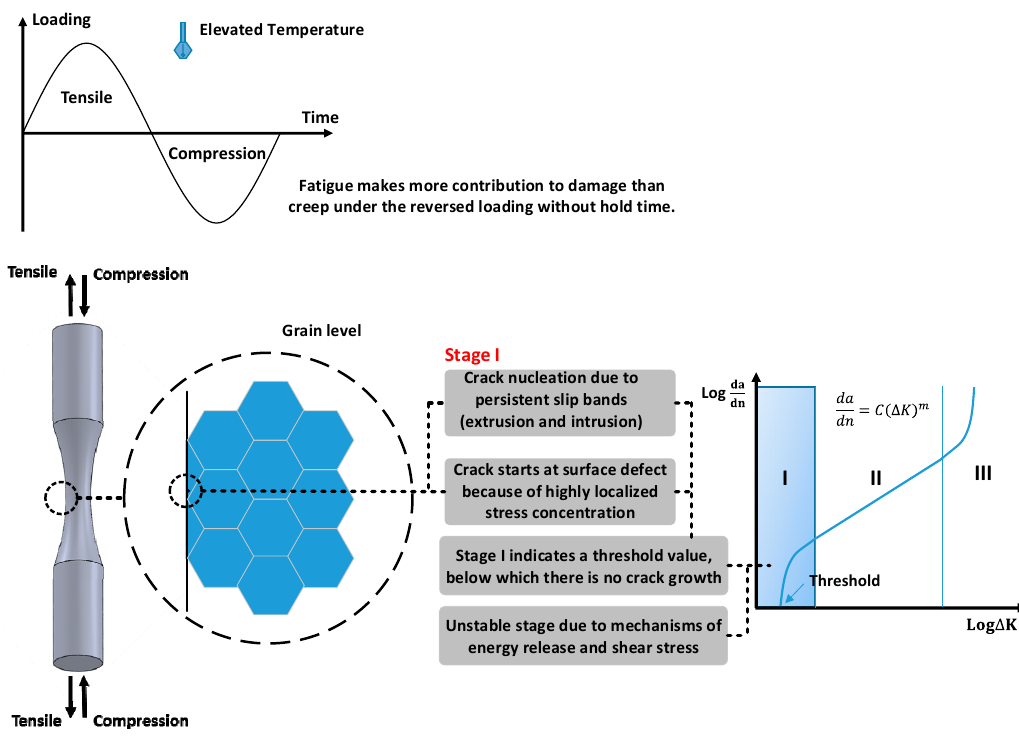
Figure 6. Stage I: Crack initiation.